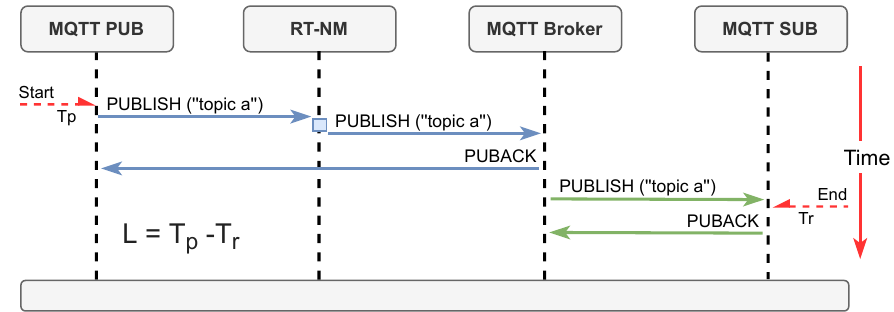
Figure 7. Latency measurement (L) in the RT-MQTT